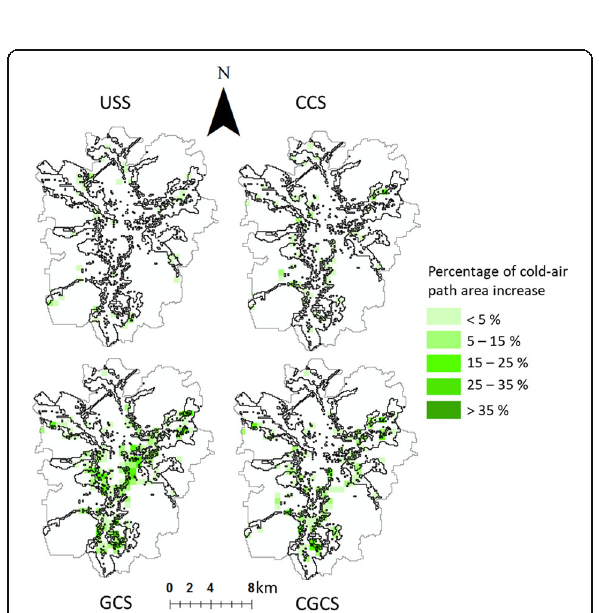
Fig. 8 The clustering of increasing areas is shown through the percentage of cold-air path increase area for all scenarios in com- parison to REF for 500 × 500 m horizontal resolution (green scales). Cold-air path surface area of REF is depicted by black lines